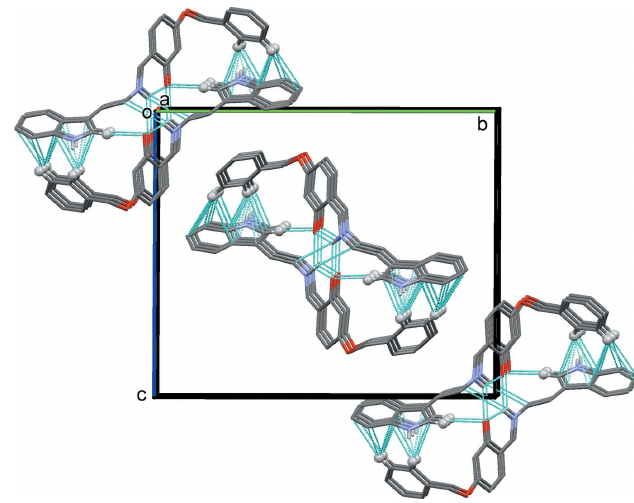
Figure 5 A view along the a axis of the crystal packing of compound (II). The hydrogen bonds and C—H (cid:2)(cid:2)(cid:2) (cid:2) interactions are shown as dashed lines (see Table 2) and only the H atoms involved in these interactions have been